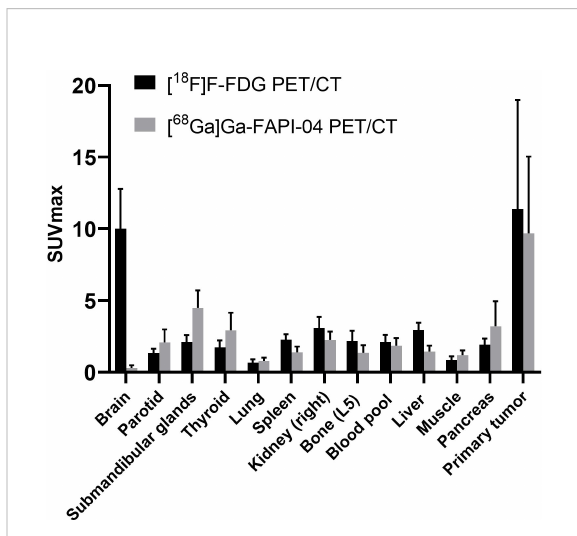
FIGURE 1 PET-based biodistribution analysis of 61 participants evaluated using [ 68 Ga]Ga-FAPI-04 PET/CT and [ 18 F]F-FDG PET/CT 1 h after tracer